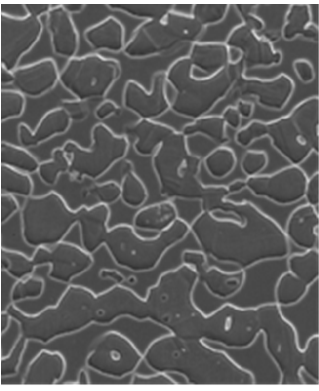
Figure 20: Duplex cold rolled.